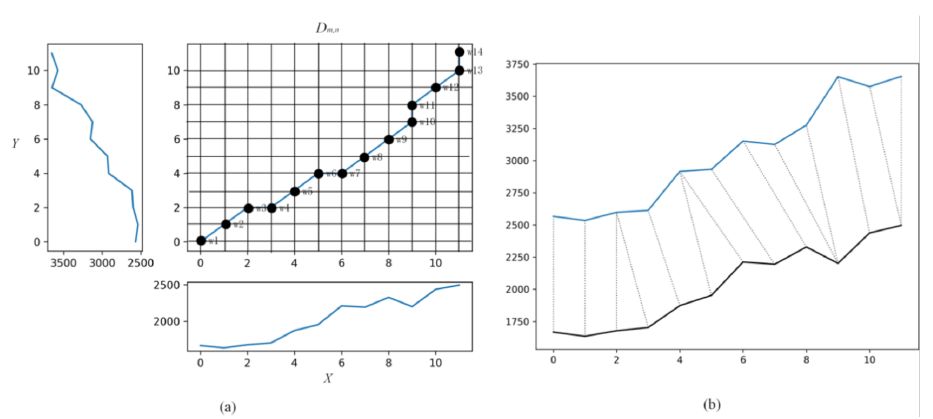
Figure 7. ( a ) An example process of finding wrapping path; ( b ) An example of final wrapping